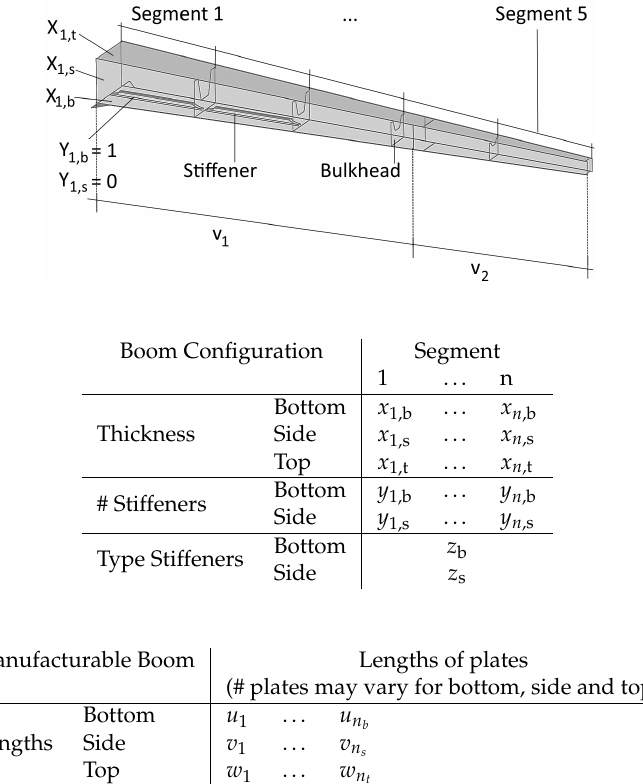
Figure 3. Box-type boom design: Variables of a boom configuration and of a manufacturable boom (adapted from Fleck et al.